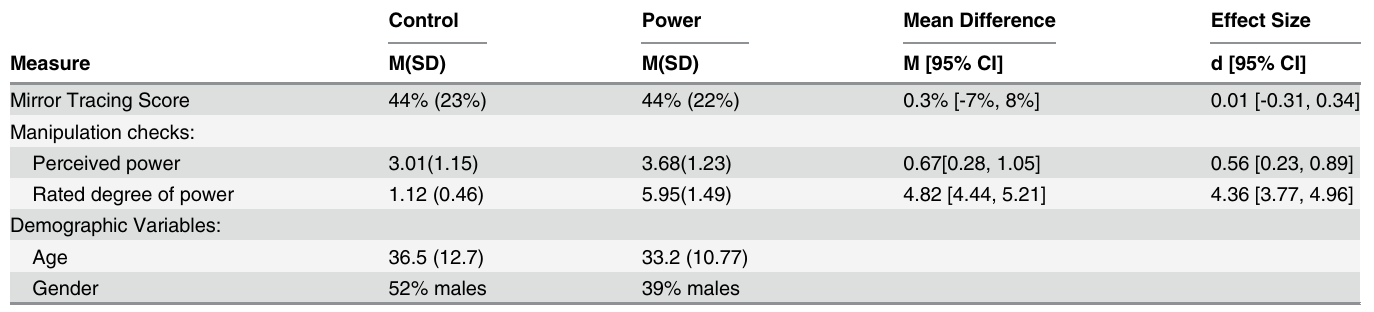
Table 3. Experiment 3: Summary of Group